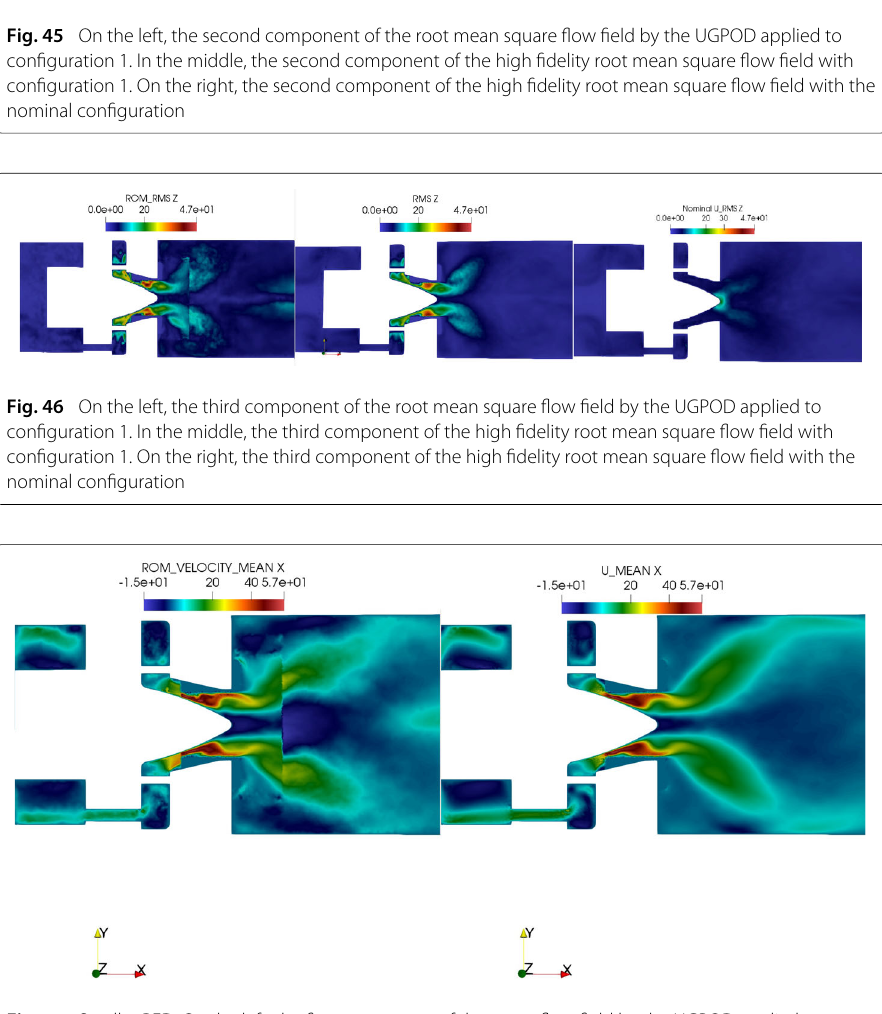
Fig. 47 Smaller RFD. On the left, the first component of the mean flow field by the UGPOD applied to configuration 1. On the right, the first component of the high fidelity mean flow field with configuration